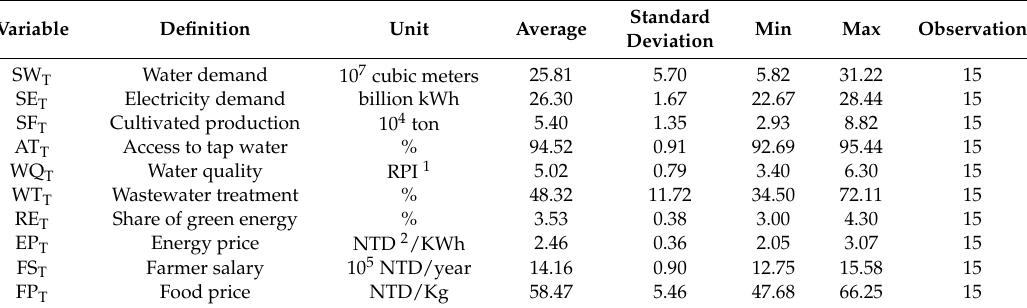
Table 2. Descriptive statistics of each variable in the urban model (Taoyuan